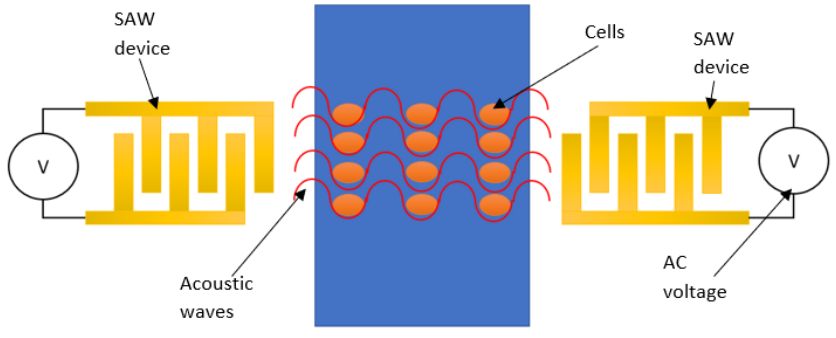
Figure 3. Illustration of cell manipulation using SAW device.